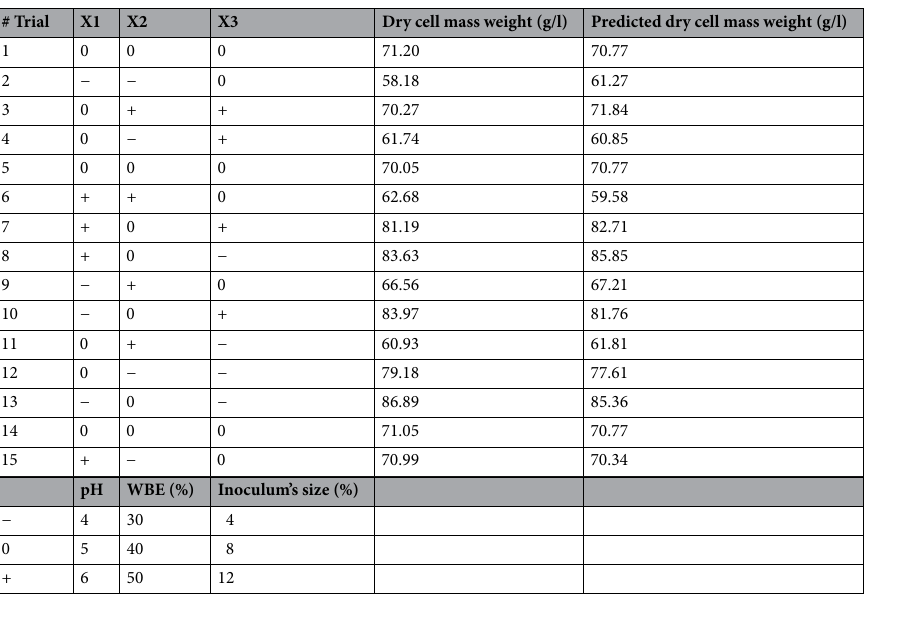
Table 5. Matrix of Box–Behnken experimental design for optimizing the biomass production of entophytic Trichoderma virens strain EG92, showing the experimental and theoretical values of dry cell mass weight under tested variables.